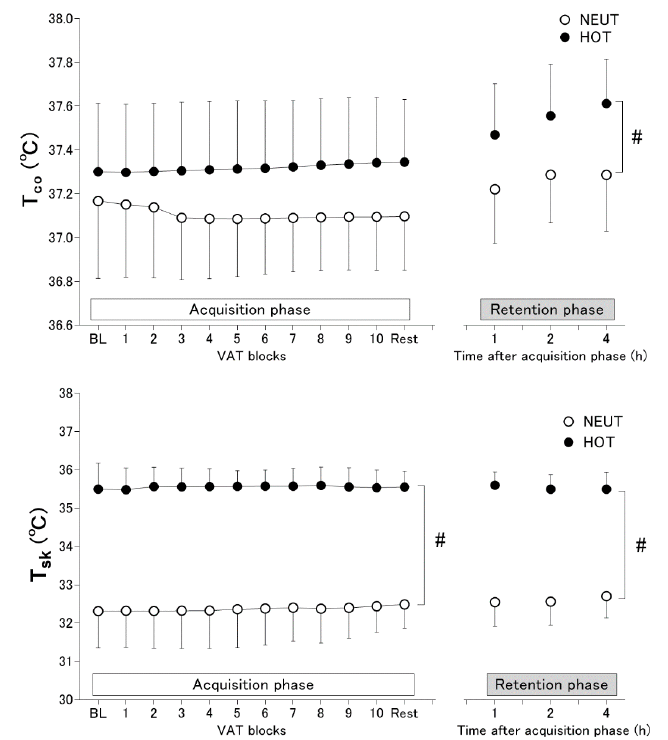
Figure 3. Core body (T co ) and mean skin (T sk ) temperatures during VAT tasks in thermoneutral (NEUT, n = 14) and hot (HOT, n = 15) environments for acquisition (left panel) and retention (right panel) phases. Values are presented as means ± SD. #, the main effect of environmental condition (all p ≤ 0.003).